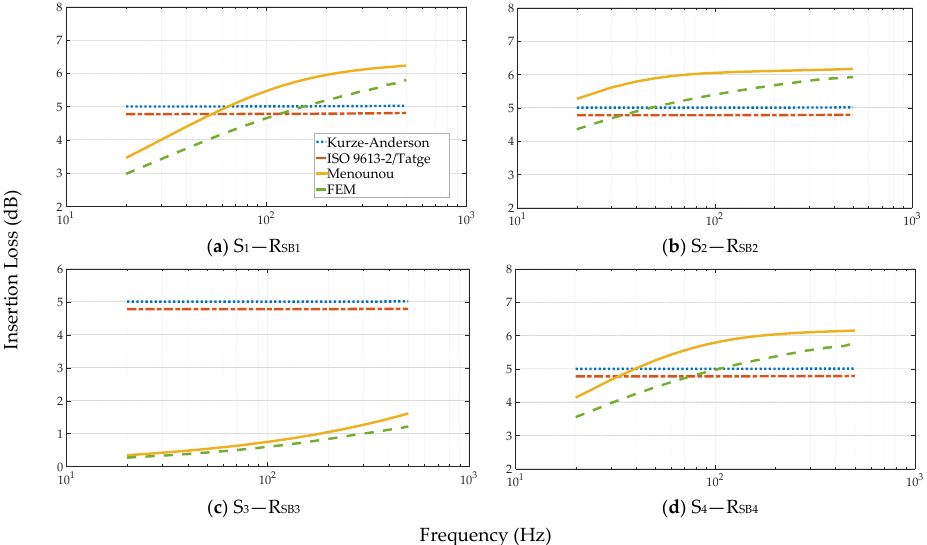
Figure 9. Comparison of calculation of insertion loss between FEM and various formulae for various source and receiver positions in the shadow border.